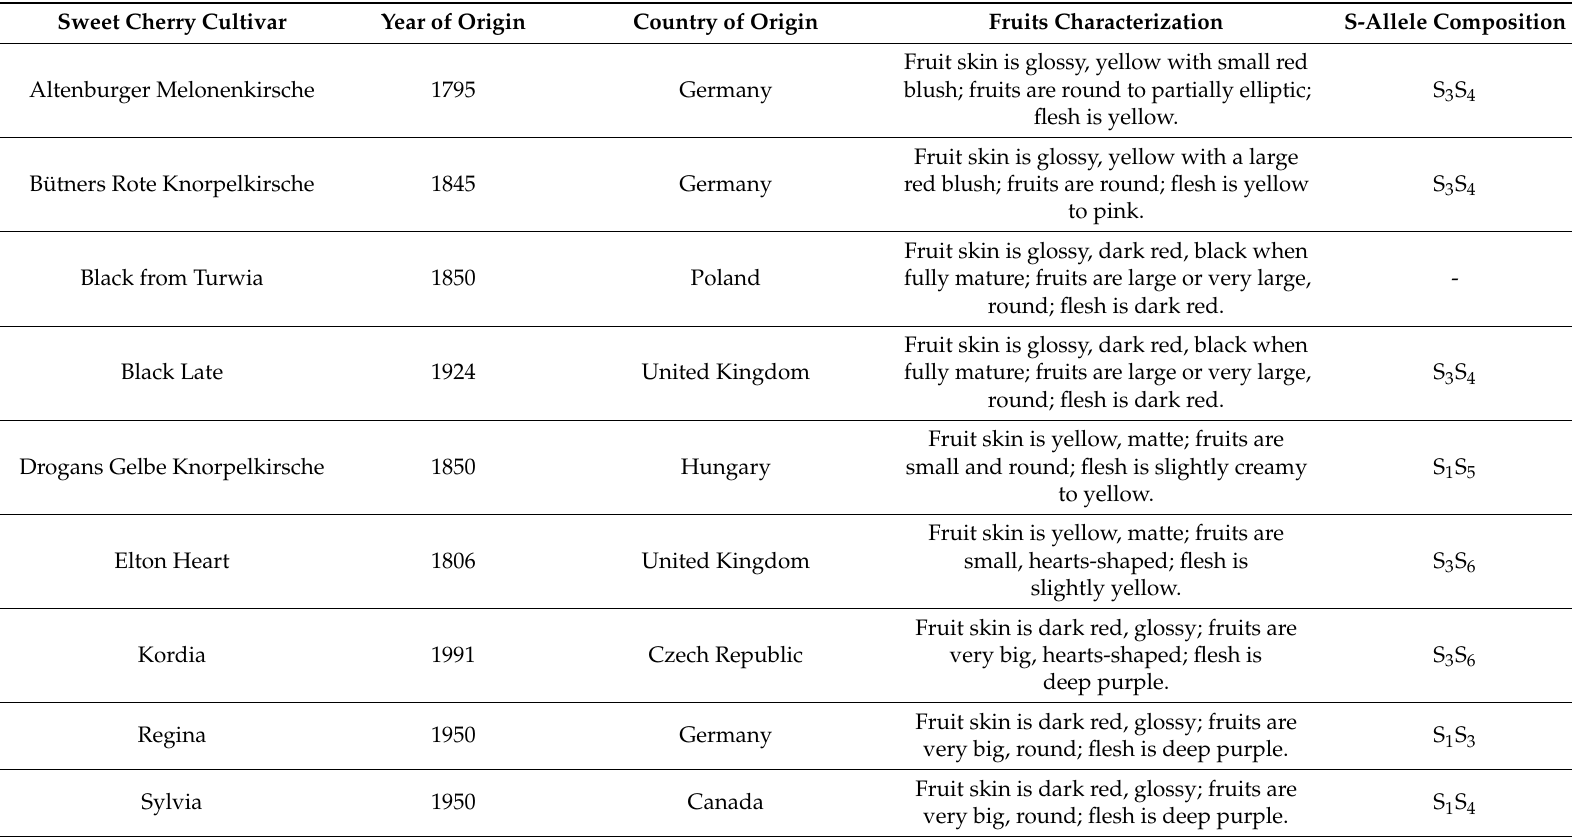
Table 1. Characterization of sweet cherry